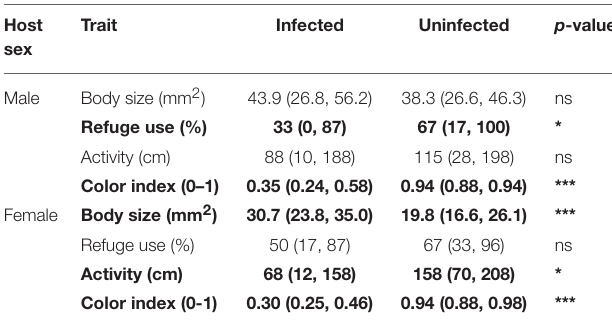
TABLE 2 | Multidimensional modification in the C. intermedius—A. dirus relationship.